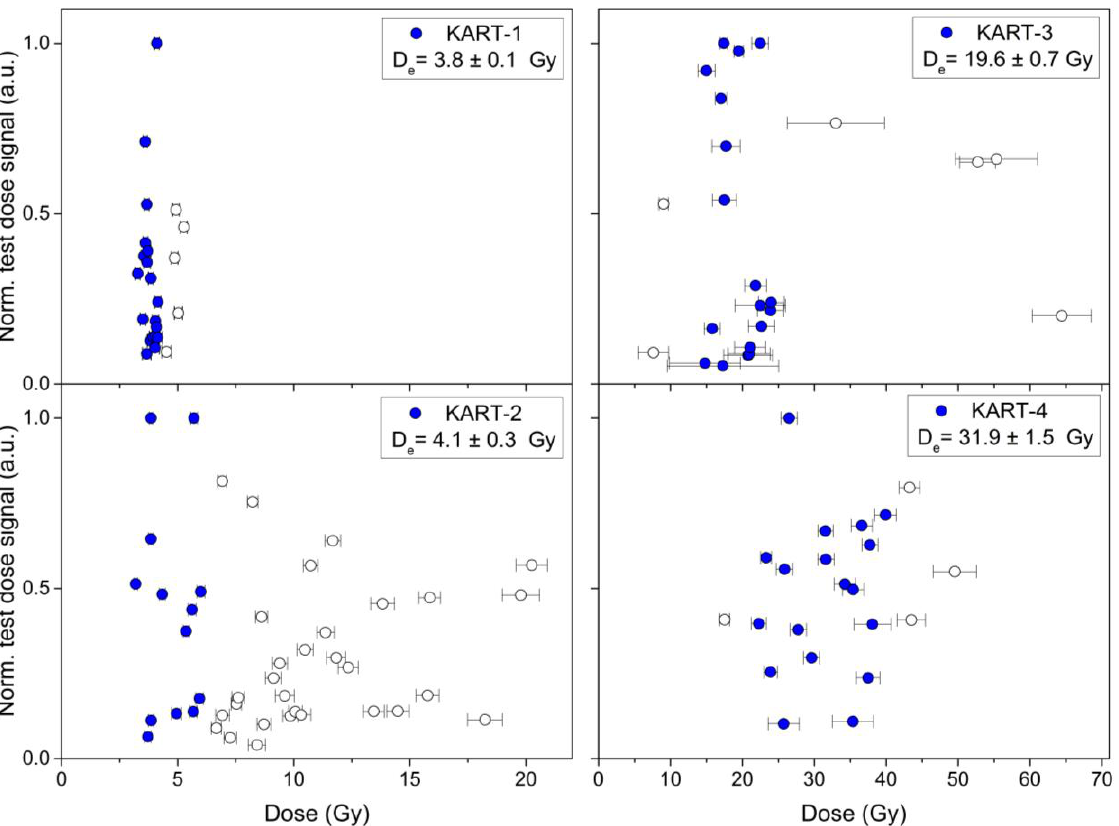
Figure 3. Dose distributions for samples KART-1, KART-2, KART-3 and KART-4. Full icons indicate the individual doses from each measured aliquot. Open icons indicate the identified outliers, excluded from the equivalent dose estimation. Note that 60% of the measured doses were not included in the age estimation of sample KART-2.